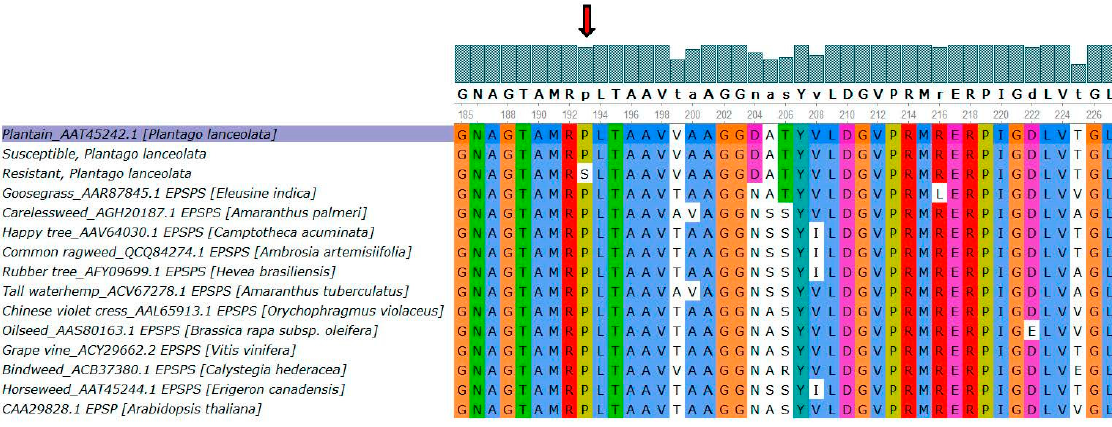
Figure 8. Multiple alignment of eleven Eudicots EPSPS amino acid sequences, the EPSPS Arabidopsis thaliana , and EPSPS Eleusine indica amino acid sequences, as described by [31], against that of plantago ( Plantago lanceolata L.) EPSPS resistant and susceptible biotypes. Highlighted amino acids indicate similarities against the plantago reference sequence. The predicted nonsynonymous variant in the resistant plantago biotype is shown with a red arrow and results in the substitution of a Proline to a Serine at position 106 (Pro-106-Ser), as described by [31].